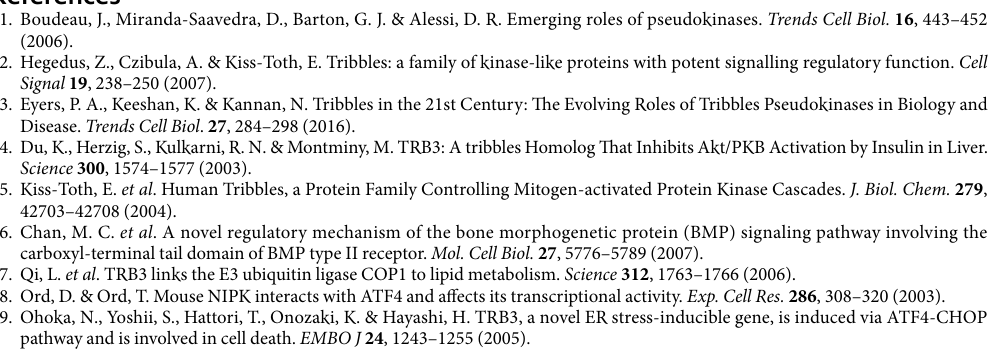
Table S3. Protein phosphorylation. AKT and ERK1/2 phosphorylation was examined by immunoblotting as previ- ously described 31 . Primary antibodies are listed online in the Supplementary Table S4. Statistical analysis. Differences between means were compared by a two tailed Student’s t- test (Graph Pad Prism, release 5.0). A value of p < 0.05 was considered to denote statistical